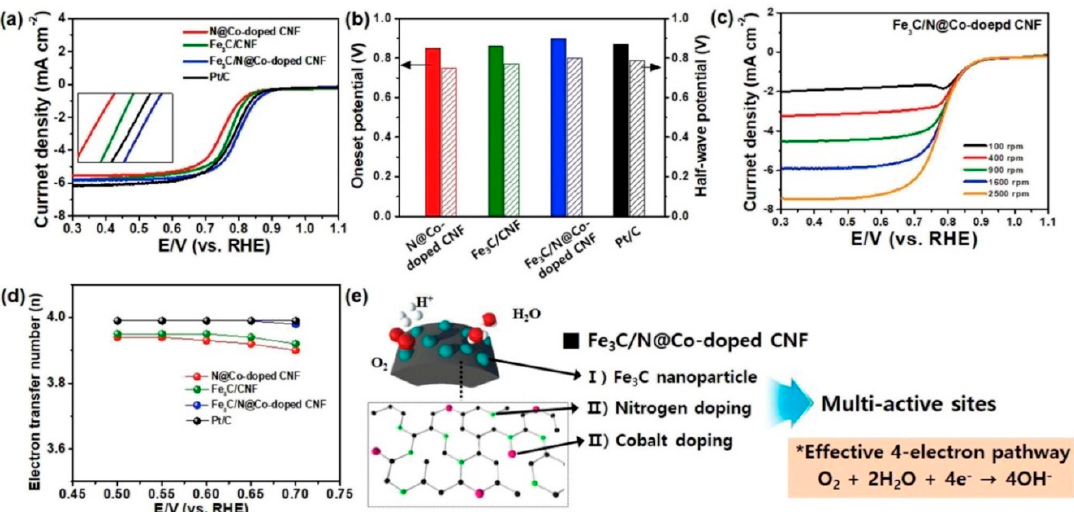
Figure 9. ( a ) Linear sweep voltammetry (LSV) curves of various catalysts at a rotating speed of 1600 rpm in O 2 -saturated 0.1 M KOH electrolyte. ( b ) A comparison of the onset and E 1/2 potential from LSV curves. ( c ) LSV curves of the Fe 3 C/N@Co-doped CNF at increasing rotating speeds ( d ) Electron transfer numbers of various catalysts in a potential range of 0.5–0.7 V. ( e ) Schematic illustration of